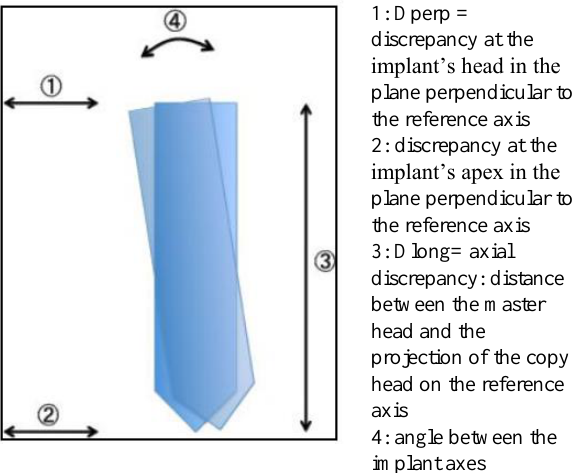
Figure 4. Parameters used to describe the differences between the master and the copy